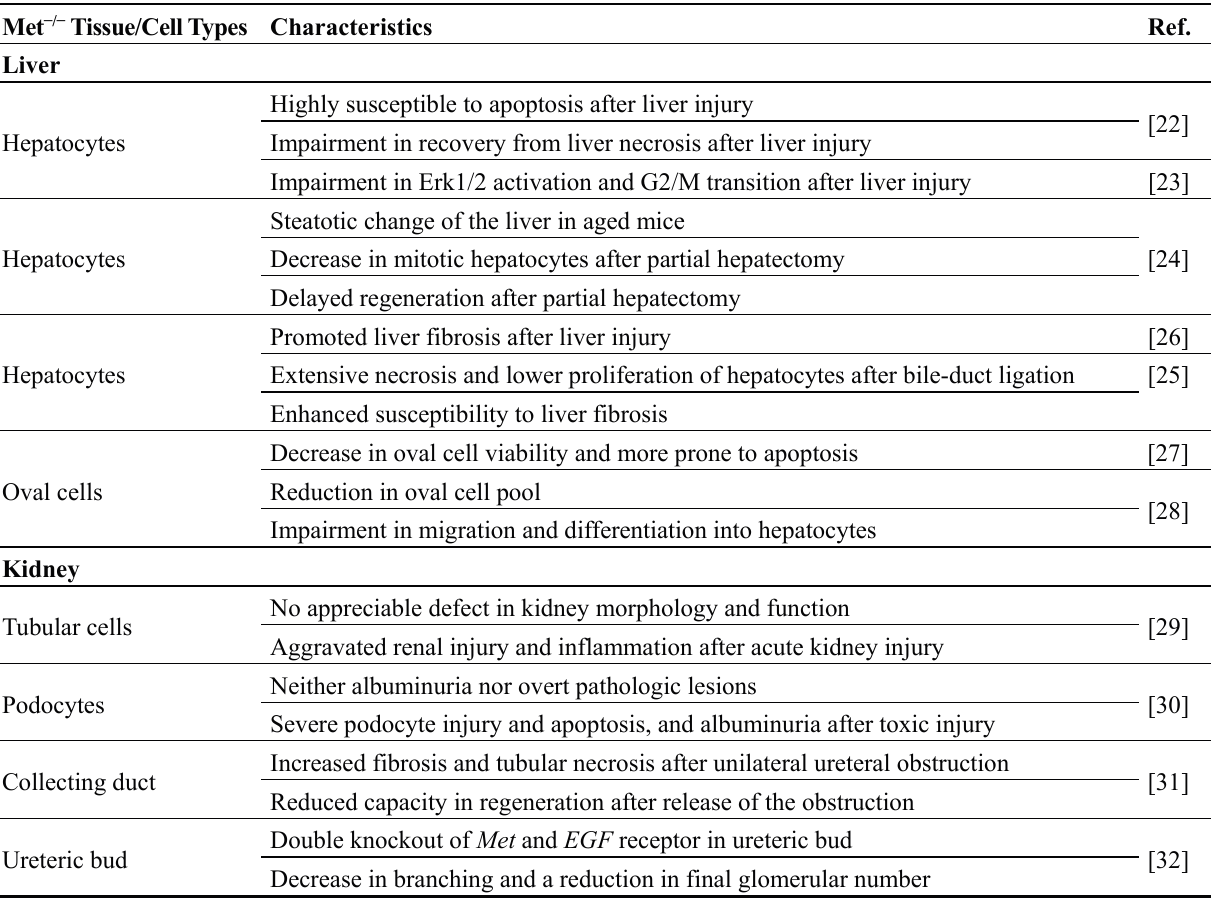
Table 1. Physiological roles of HGF deduced from conditional knockout mice. Met − / − Tissue/Cell Types Characteristics